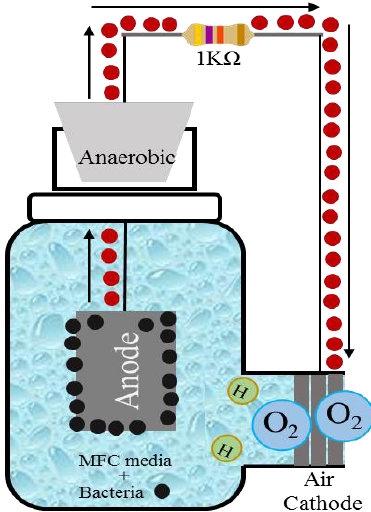
Figure 5. Single chamber microbial fuel cell.